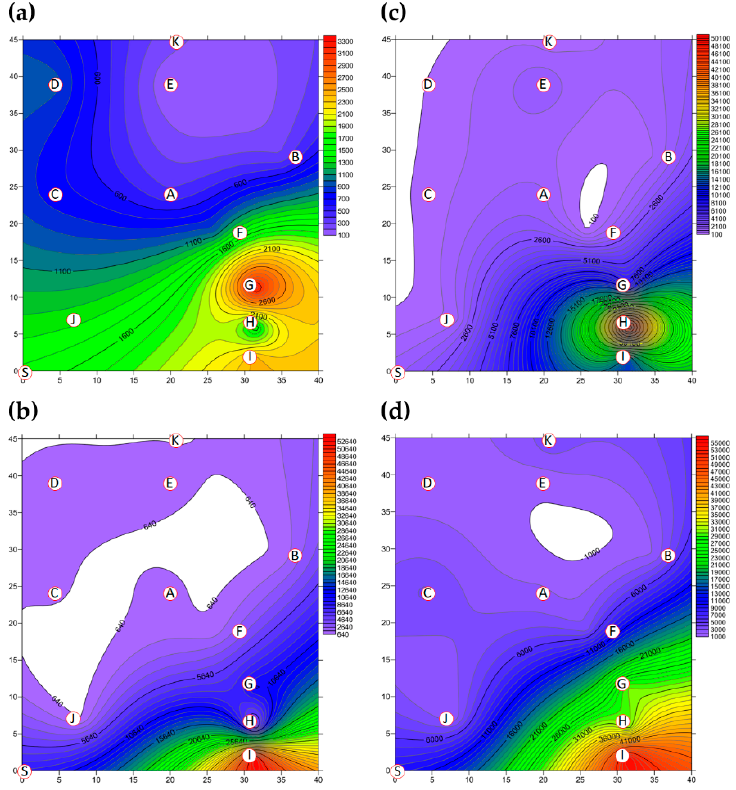
Figure 7. The FBs (CFU m − 3 ) present as ( a ) LPBs and ( b ) SPBs in Market A before operations commenced and ( c ) LPBs and ( d ) SPBs present after operations had finished. Red circular dots with English titles represent the sampling locations. The bioaerosol levels in the areas marked in white are below the cutoff level.